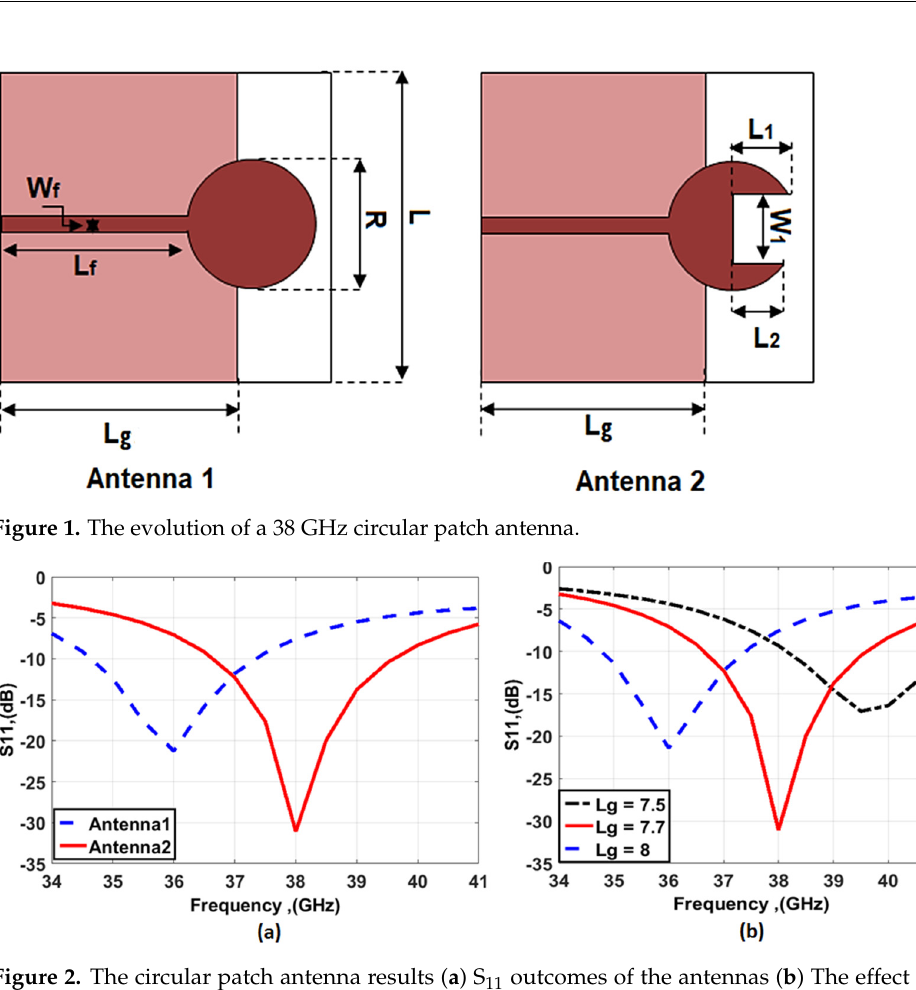
Figure 4. The suggested 38 GHz antenna ( a ) 2D configuration (L = 12 mm, L1 = 2.45 mm, L2 = 2.35 mm, W1 = 2.2 mm, Wf = 0.4 mm, Lf = 7 mm, and Lg = 7.7 mm) ( b ) The S 11 result. 3. Four-Port MIMO Antenna and Its Parametric Analysis This section discusses the structure of a 4-port MIMO antenna and the method used to enhance isolation between elements. As indicated in Figure 5, the MIMO antenna is discussed in two designs with an (L × L) size of 25.95 × 25.95 m 2 . The single antenna unit discussed in the previous section is copied three times and placed orthogonally to each other as depicted in Figure 5a, and the detachment (d = 3 mm) between the four elements is the same as depicted in Figure 5a. To enhance the isolation between ports, four stubs with a width of Ws = 0.5 mm and a length of Ls = 12 mm are utilized as depicted in Figure 5b. Figures 6 and 7 depict the simulation results to compare the two designs and demon- strate the influence of adding the four stubs on the separation between antenna elements. As depicted in Figure 6, S 11 with and without stubs shows that the two antennas operated at approximately the same frequency bands. The return loss between antenna elements (S 21 /S 31 /S 41 ) is improved by around 5 dB by introducing the four stubs, especially at 38 GHz, which validates the MIMO antenna with stubs to be used instead of without stubs in this paper.